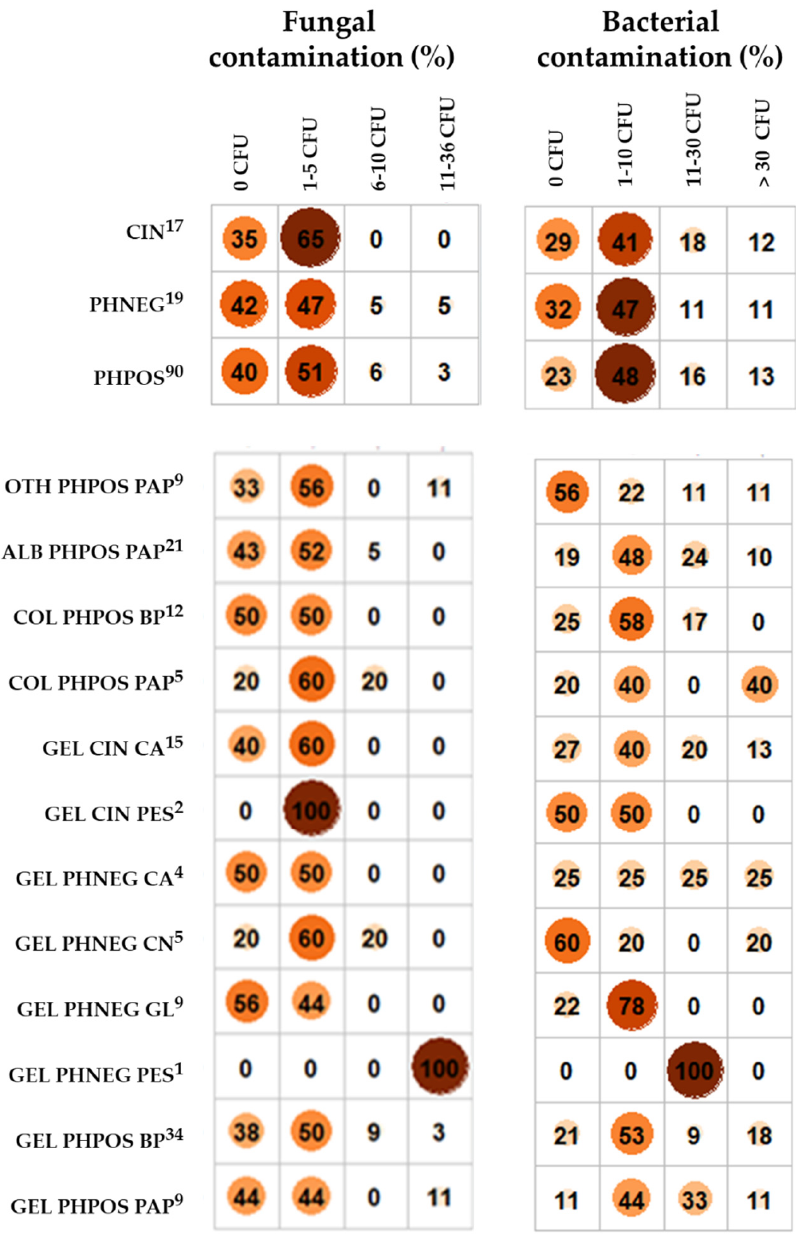
Figure 1. The relative frequencies of the categories of total fungal and total bacterial load (the number of fungal or bacterial CFU isolated from a sample) for samples categorised by the type of material (CIN, PHPOS, PHNEG) and by a combination of the type of material and the material of the light-sensitive layer and the carrier. Legend: CIN—cinematographic material, PHNEG—photographic negative, PHPOS—photographic positive, GEL—gelatine, ALB—albumen, COL—collodion, OTH— other minor types (such as autotype, ozotype, collotype, cyanotype, platinotype, salt paper and gumoil printing), CA—cellulose acetate, PES—polyester, CN—cellulose nitrate, PAP—paper, BP— baryta paper, and GL—glass. The upper index indicates the number of analysed